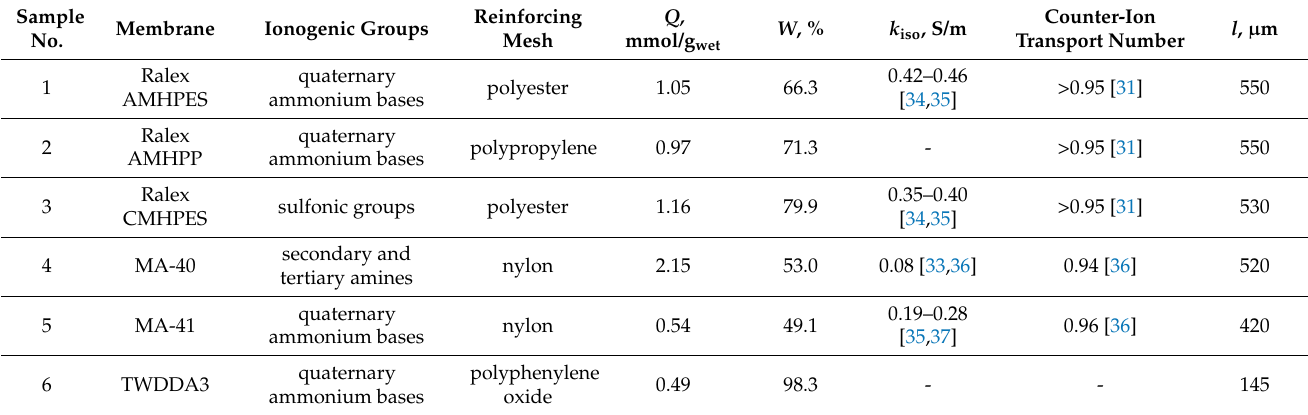
Table 1. The physical–chemical properties of